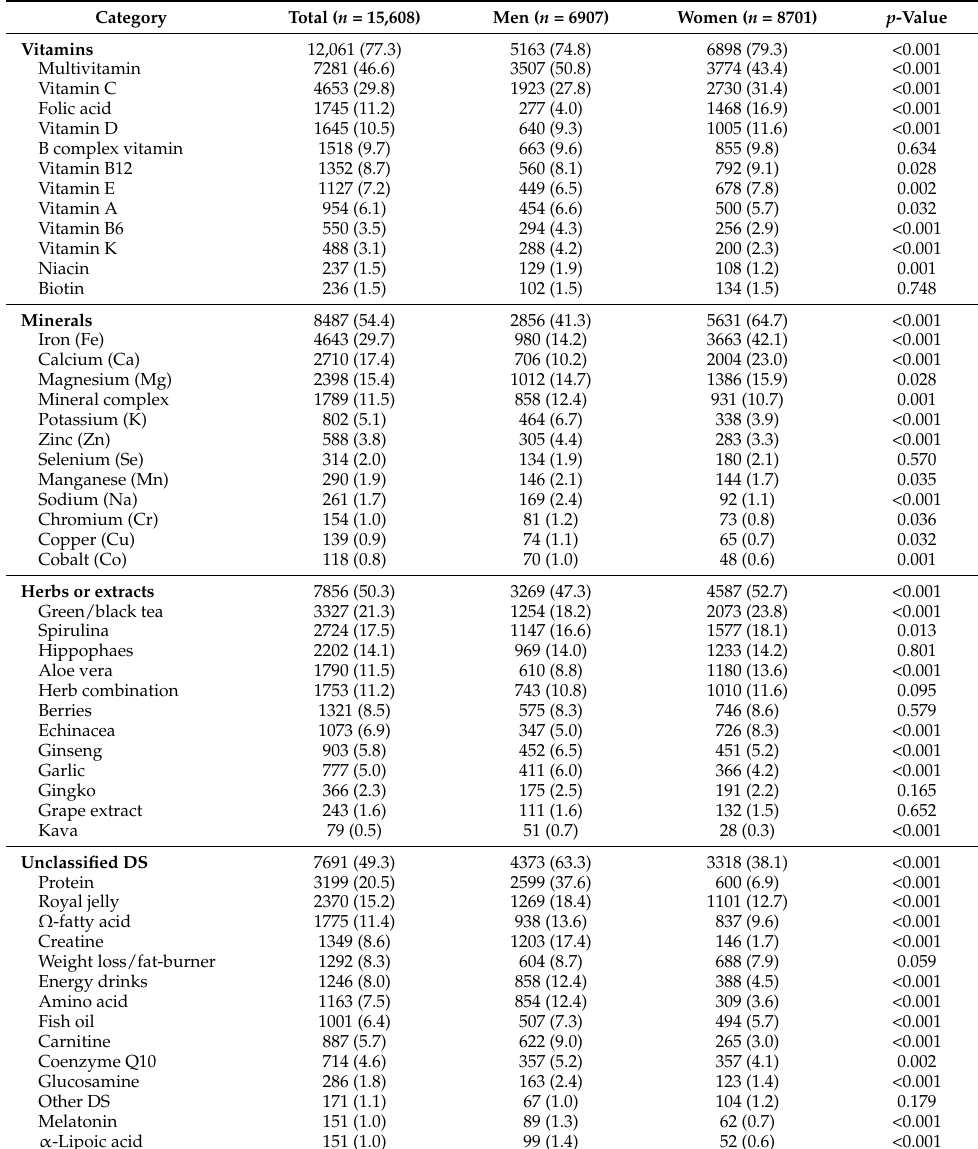
Table 6. Absolute and relative frequencies in parenthesis (%) of DS types used by DS users overall and according to sex. The p -values of chi-square tests are